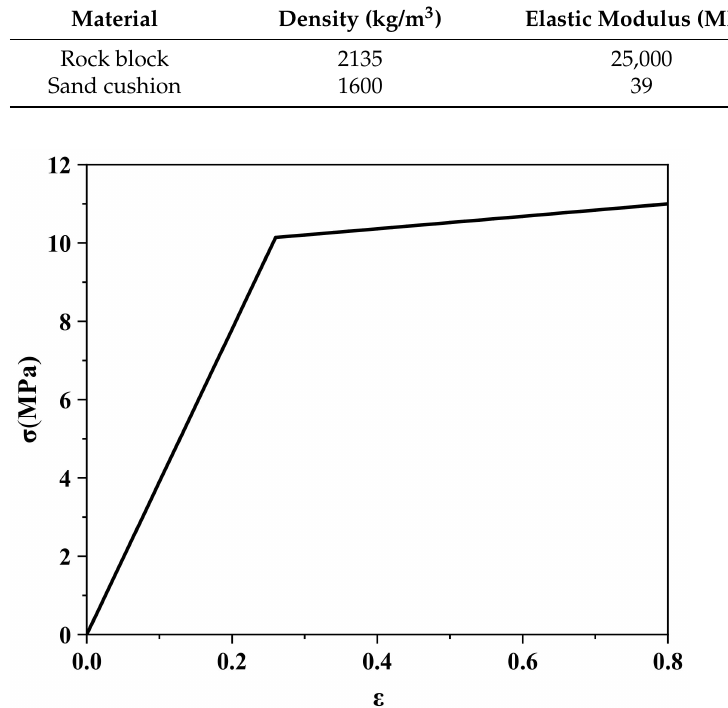
Table 5. Mechanical parameters of each material.